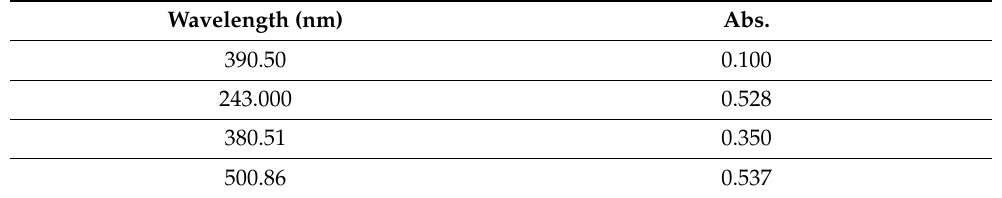
Table 3. UV ‐ vis spectra of chemical ZnO ‐ NPs. Table 3. UV-vis spectra of chemical